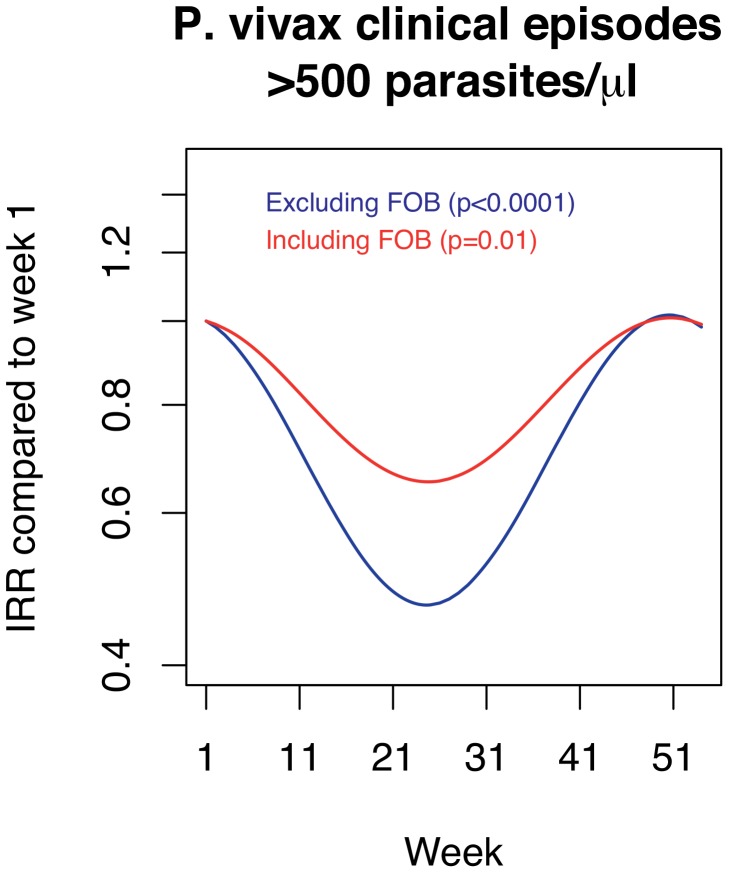
Seasonality of P.
vivax clinical episodes (as compared to the first week of January, where incidence peaked) excluding molFOB (blue) and adjusted for molFOB (red).
molFOB accounts for approximately 50% of the seasonal variation in incidence. IRR = incidence rate ratio.